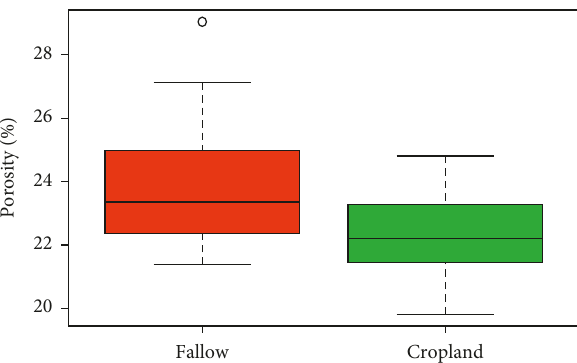
Figure 7: Soil porosity under cropland and fallow land.